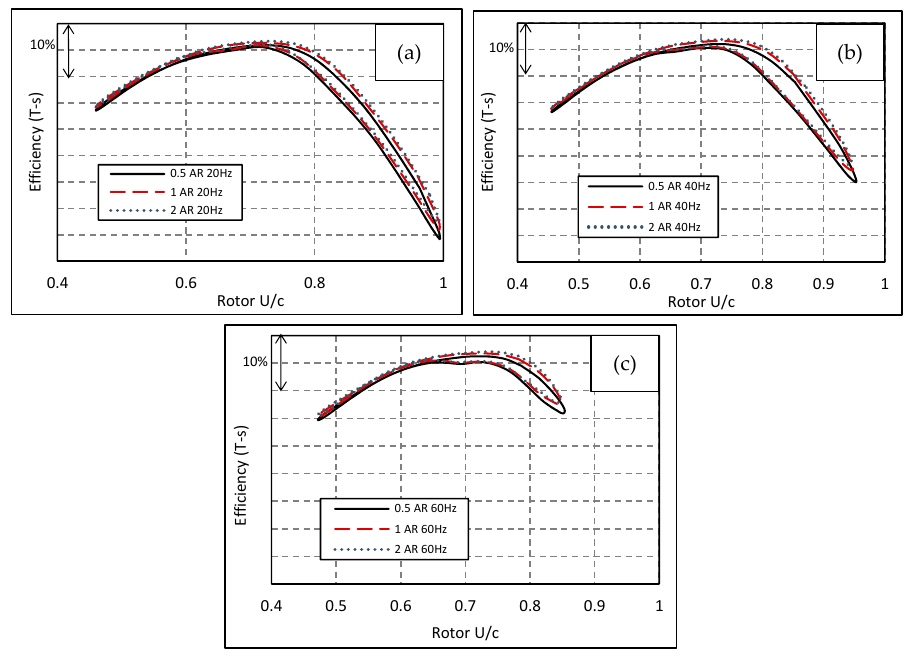
Figure 13. Turbine rotor efficiency. ( a ) 20 Hz; ( b ) 40 Hz and ( c ) 60 Hz.